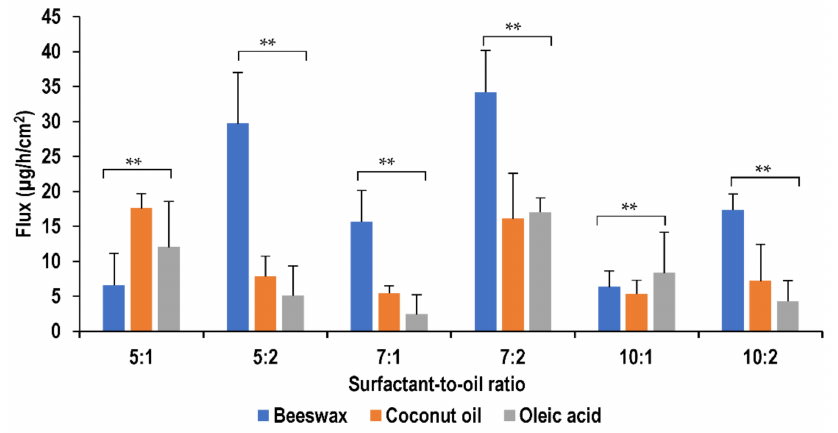
Figure 10. Effect of oil type on flux of lidocaine nanoemulsion through pig skin membrane (** p > 0.05).